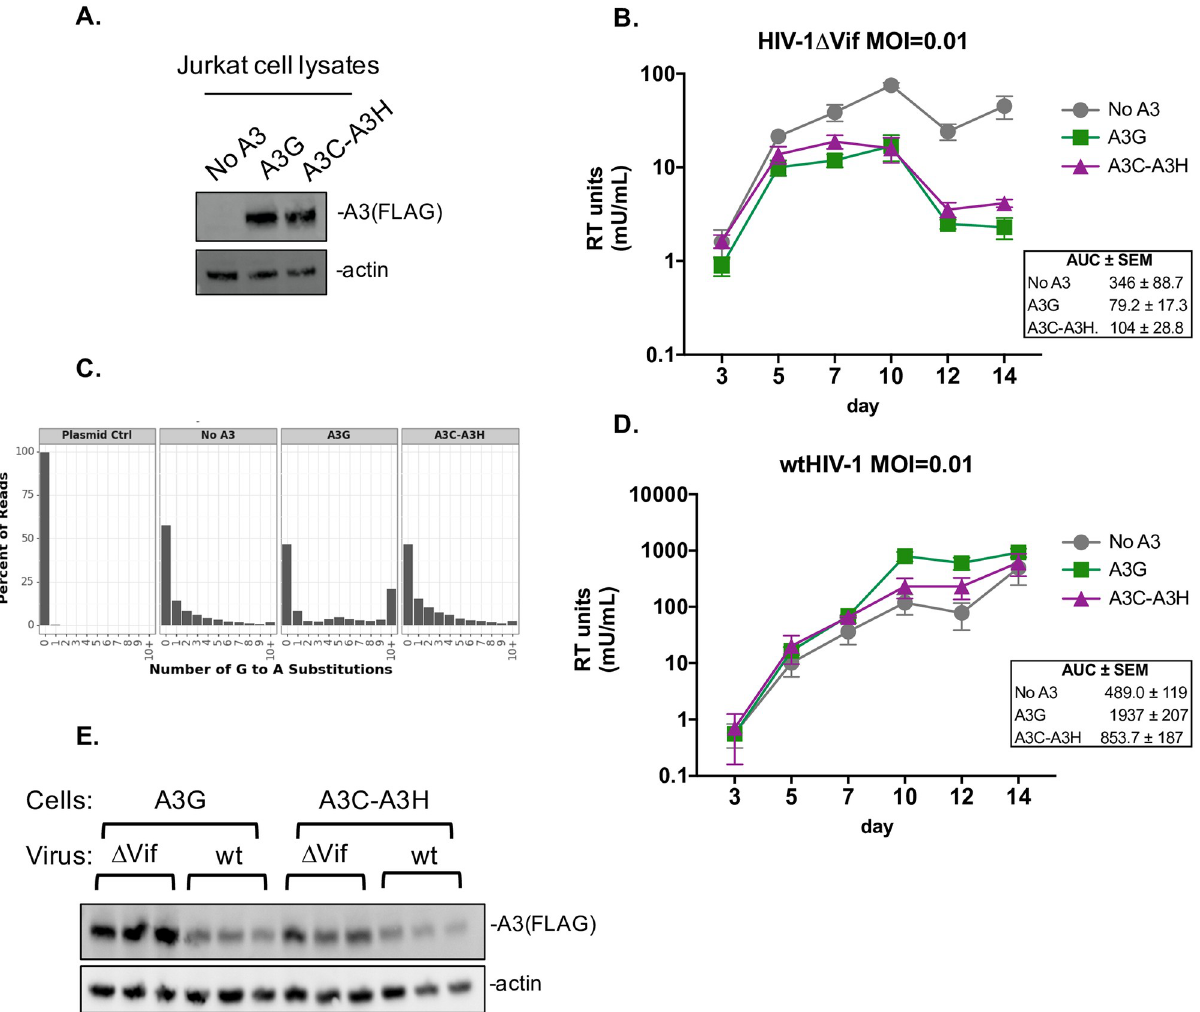
Fig 5. A3C-A3H suppresses HIV-1 Δ Vif spreading infection to day 14. (A) Western blot of the Jurkat cells constitutively expressing no A3, A3G, or A3C-A3H hap II (shortened to A3C-A3H) probed with anti-FLAG for the A3 levels and actin as a loading control. (B) Spreading infection kinetics of a replication-competent HIV-1 with a deletion that spans the Vif open reading frame (called HIV-1 Δ Vif). The Jurkat cells expressing no A3 (circles, grey line), A3G (squares, green line), or A3C-A3H hap II (shortened to A3C-A3H, triangles, purple line) were infected at a low MOI (MOI = 0.01) in triplicates. Virus production was monitored over time by collecting supernatant and measuring RT activity (mU/mL) using a SG-PERT assay. Error bars represent the standard error across the 3 biological replicates. To compare spreading infection kinetics, area under the curve (AUC) was calculated for each biological replicate. The mean AUC and standard error of the mean are represented to the right. (C) A3 mediated hypermutation analysis of gDNA from cells harvested on day 14. Paired-end sequencing reads were analyzed for G-to-A mutations. Data is shown as frequency distribution bar graphs of the percent of reads by the number of G-to-A substitutions in each read for each A3 tested. Plasmid control was used as a sequencing control and a no A3 sample was used to distinguish mutations that occurred throughout the 14-day time course. Frequencies are calculated as the average frequency of each biological infection replicates and read counts are shown as the sum of the reads for each replicate. (D) Spreading infection kinetics of a replication-competent wtHIV-1 (LAI isolate). Jurkat cells expressing no A3 (circles, grey line), A3G (squares, green line), and A3C-A3H hap II (shortened to A3C-A3H, triangles, purple line) were infected in triplicate at a low MOI (MOI = 0.01). Virus production was monitored over time by collecting supernatant and measuring RT activity (mU/mL) using a SG-PERT assay. Error bars represent the standard error across the 3 biological replicates. To compare spreading infection kinetics, area under the curve (AUC) was calculated for each biological replicate. The mean AUC and standard error of the mean are represented to the right. (E) Western blot of cell lysates collected on day 14 from HIV-1 Δ Vif infection (B), shortened to Δ Vif, and from wtHIV-1 infection (D), shortened to wt. Cells expressing A3G or A3C-A3H hap II were evaluated for their intracellular expression levels of A3 in each of the triplicate infections. The anti-FLAG antibody was used to probe for the FLAG tagged A3s and actin was used as a loading control.